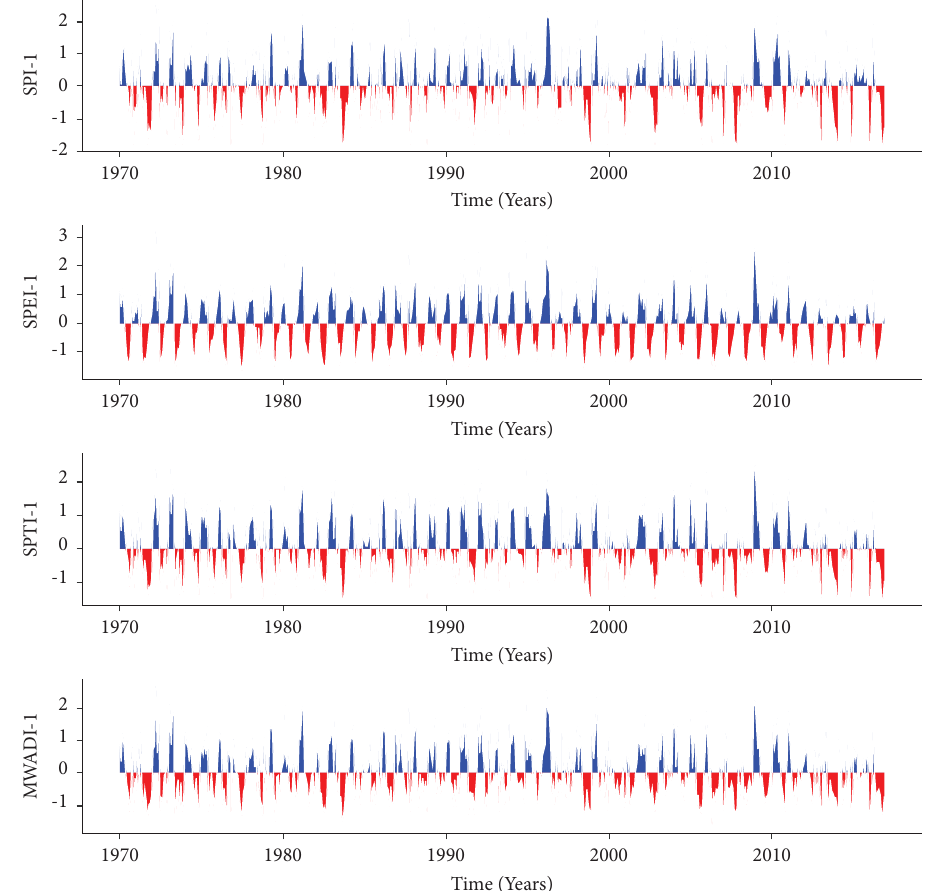
Figure 9: Temporal plots comparison of MWADI-1 with SPI-1, SPEI-1, and SPTI-1 at the Astore